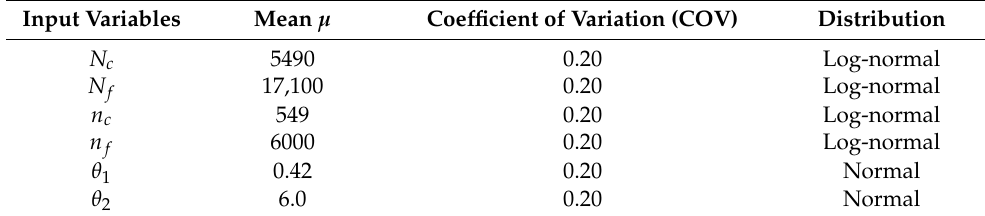
Table 9. Values and distribution parameters of input